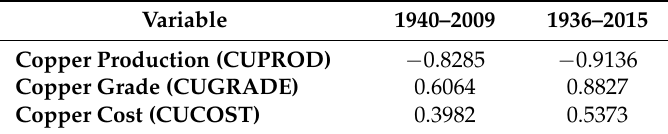
Table 4. Very Serious Failures correlations with Canonical Variables.